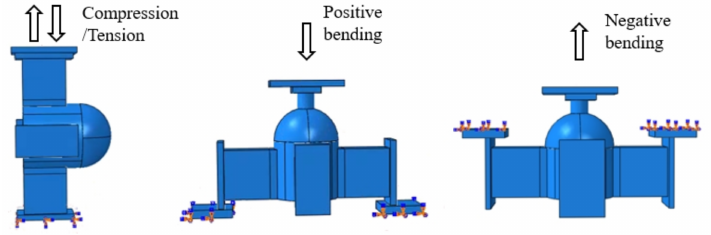
Figure 7. Loading scenarios for BBC joints. Table 2. Joints for parametric